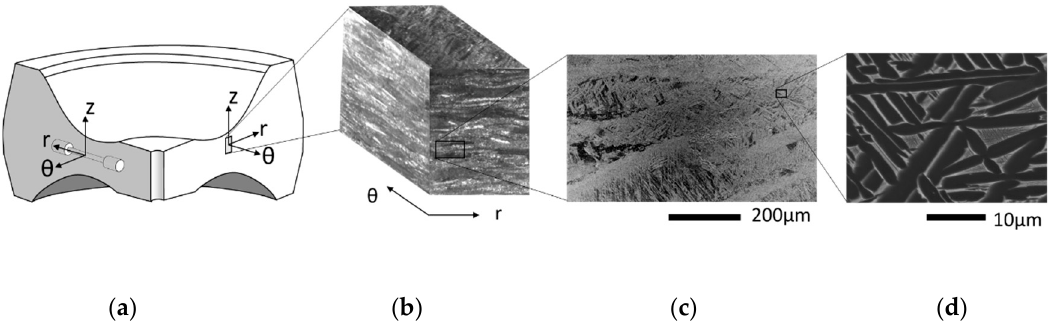
Figure 1. ( a ) Schematic of the forged disk with the reference frame used in this study and the region of interest for microstructure characterization and fatigue tests; ( b ) Macrography of the microstructure in 3 orthogonal directions ( c ) α lamellae structure formed in millimeter large and elongated prior β grains, ( d ) residual β -phase layers (in white) and α needles formed during aging in the α / β field.